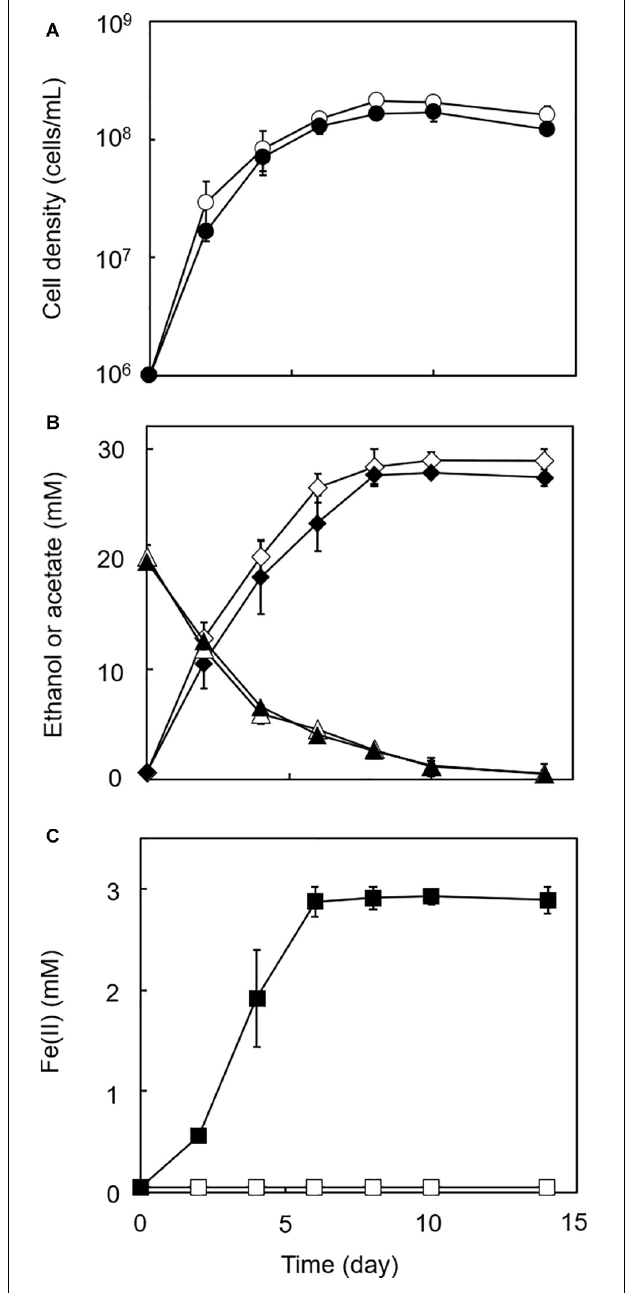
FIGURE 2 | Growth-dependent HFO reduction by strain GT1 under organotrophic conditions. Strain GT1 was cultivated on ethanol (20 mM) in the presence or absence of HFO. (A) Cell density, (B) concentration of ethanol (triangles) and acetate (diamonds), and (C) Fe(II) concentration were periodically determined during cultivation. Closed symbols, cultures with HFO. Open symbols, cultures without HFO. Data are presented as the means of three independent cultures, and error bars represent standard